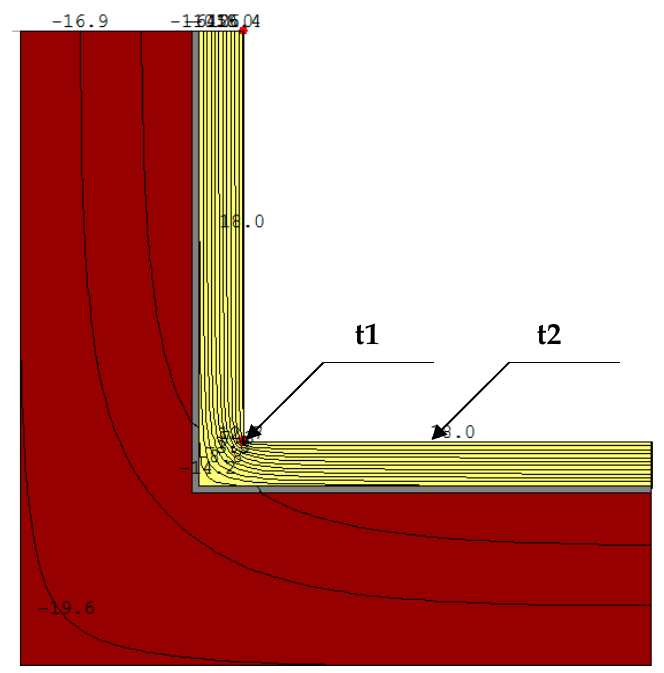
Figure 10. Distribution of isotherms for variant A.